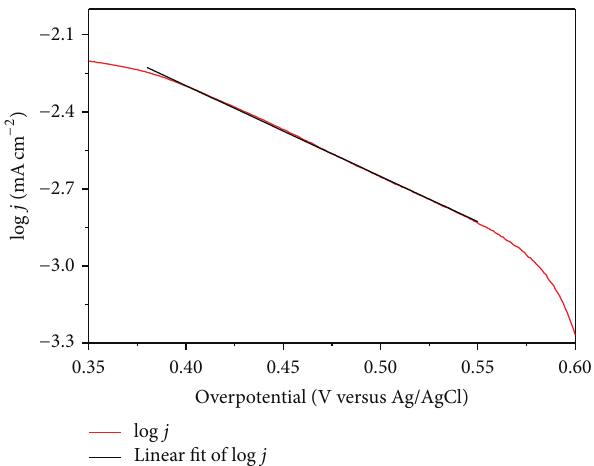
Figure 5: Tafel plot for the electrochemical reduction of Zn 2+ on GaN electrode. The scan rate was 10mVs −1 .